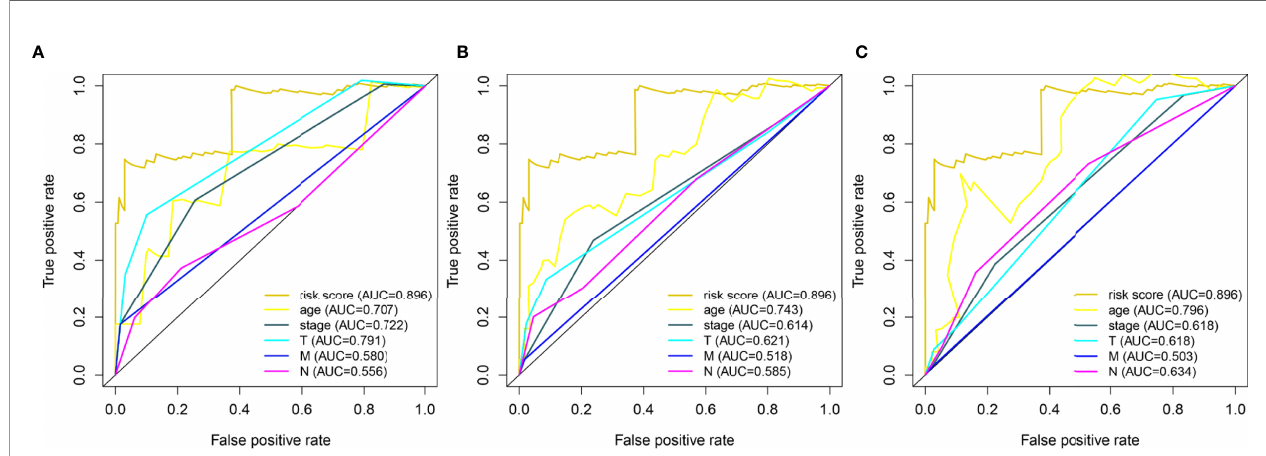
FIGURE 6 | Time-dependent ROC curves for risk score and clinical data based on 5 metabolism-related genes. A total of 133 HER2-positive samples were included in the analysis. (A) 1 year- (B) 3 year-